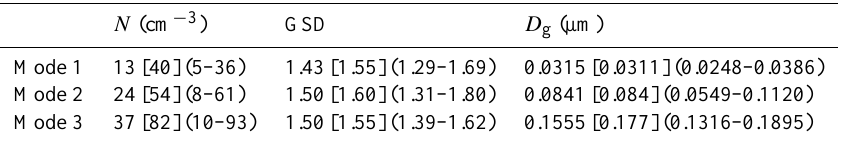
Table 1. Median modal properties of the aerosol number size distribution as observed at Mt. Zeppelin, March 2000–March 2010. 25–75th percentile range within brackets, mean values within square brackets. Given are the median of modal number concentration ( N , cm − 3 ) , modal geometrical standard deviation (GSD) and modal geometrical mean diameter ( D g , µm).